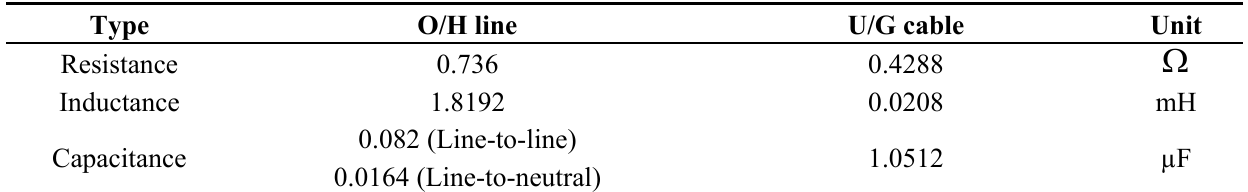
Table 15. Comparison of line parameters of 1.6 km LVDC distribution line.